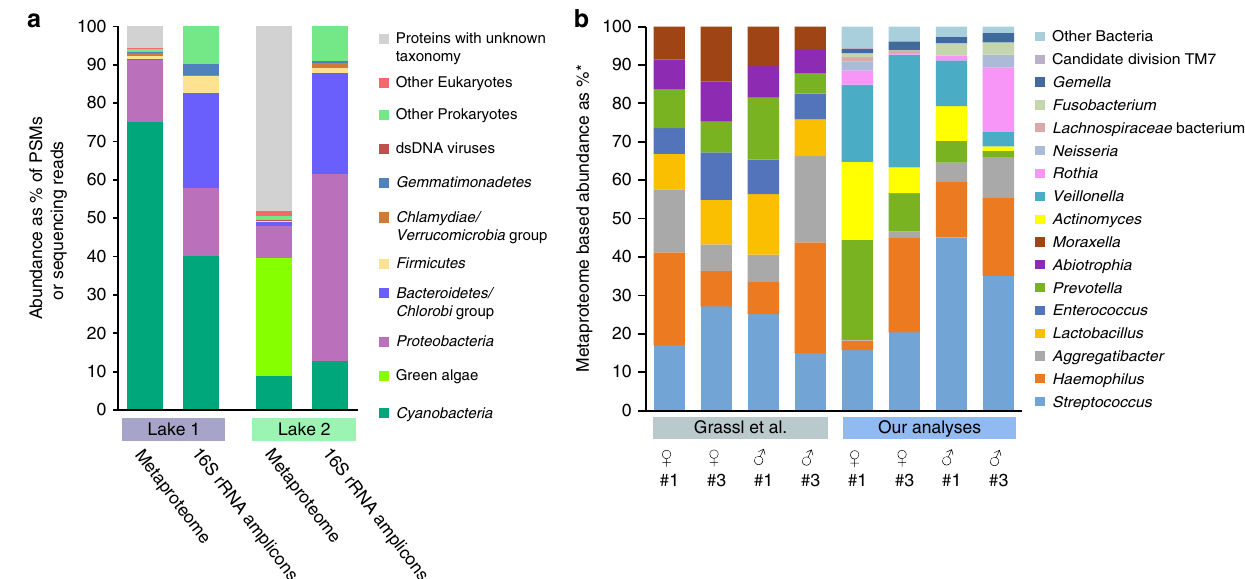
Fig. 7 Two application examples using metaproteomics of estimating species biomass in communities. a Comparison of phylum level quanti fi cation of two soda lake biomats using metaproteomics and 16S rRNA gene amplicon sequencing. b Re-analysis of a published saliva metaproteome data set by Grassl et al. 9 using our method and comparison with the original analysis. *For the Grassl et al. analyses the abundances are given in % of the summed MS intensities of the 10 most abundant peptides per genus across all samples. For our analyses the abundances are given as % of all PSMs from proteins inferred by FidoCT with an FDR of 5% and at least 2 protein unique